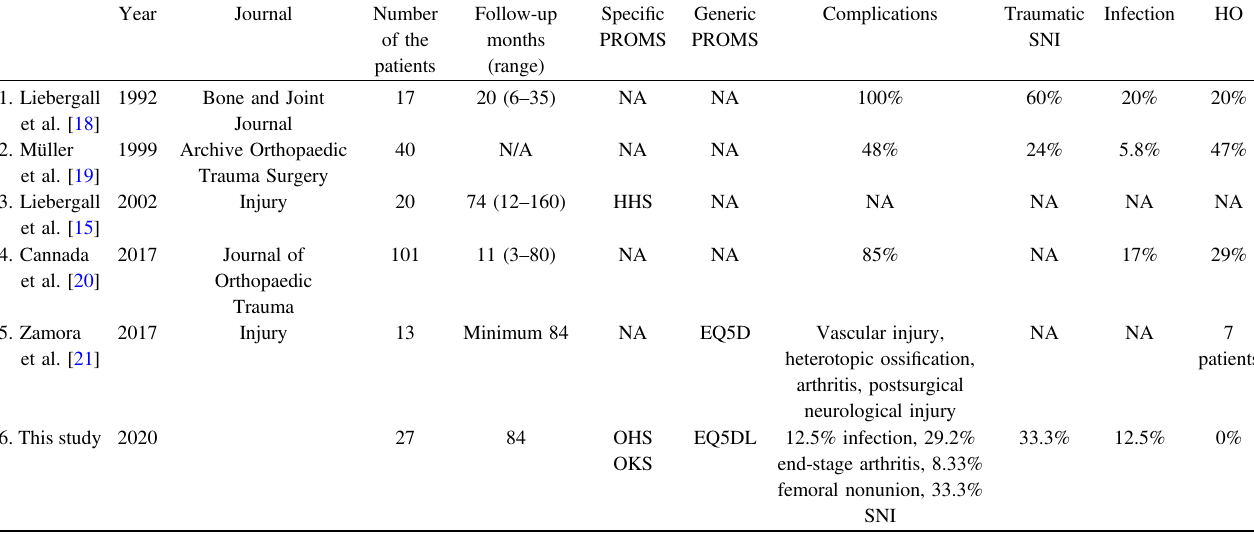
Table 5. Studies reporting ipsilateral femoral and acetabular